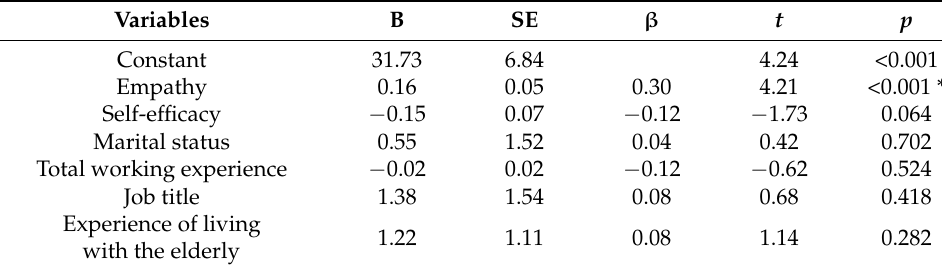
Table 5. Influential factors relating to elderly nursing